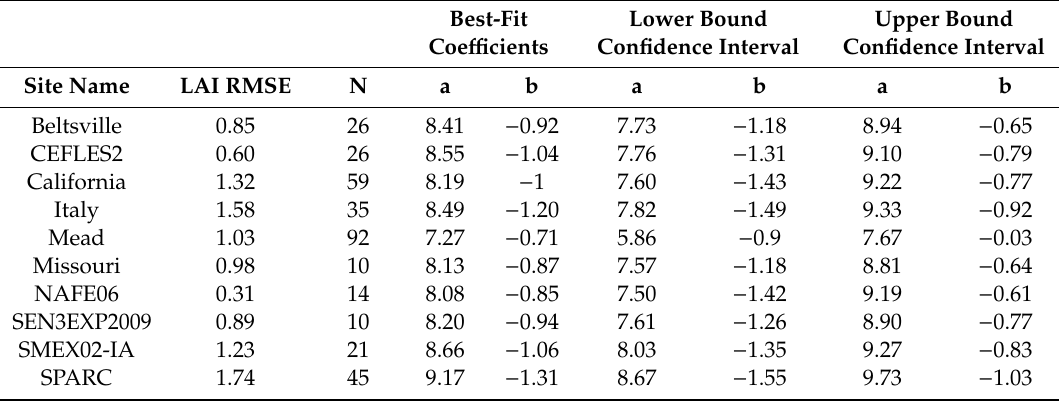
Table 3. Leave-one-site-out LAIGROUND LANDSAT regression retrieval performance using Equation (4). a and b are the leave-one-site-out regression coefficients defined in Equation (4). Lower Bound Best-Fit Coefficients